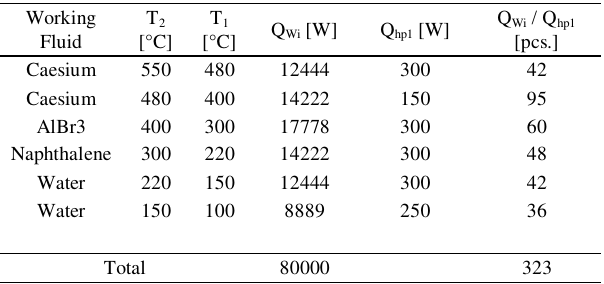
Table 3. Calculation